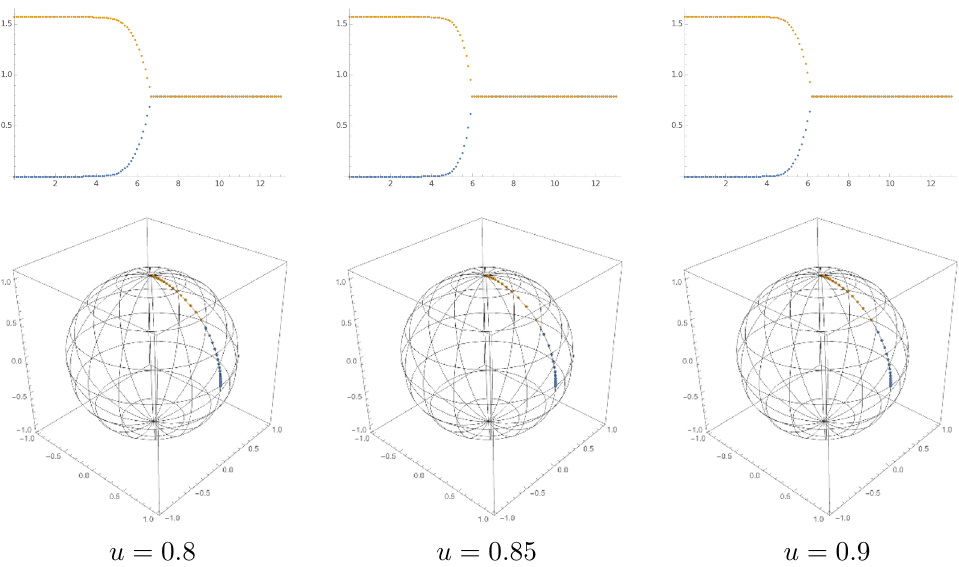
Figure 12 . Evolutions of internal orientations α 1 , 2 of the orthogonal vortices with the velocities u = 0 . 8 , 0 . 85 , 0 . 9 above the